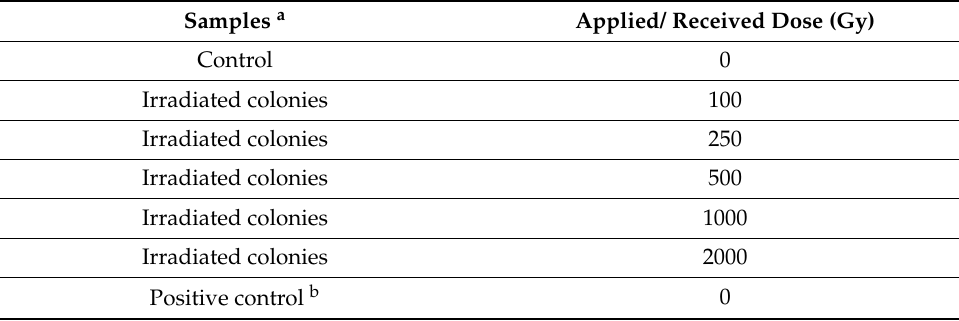
Table 1. Accelerated Fe ion radiation doses applied for each